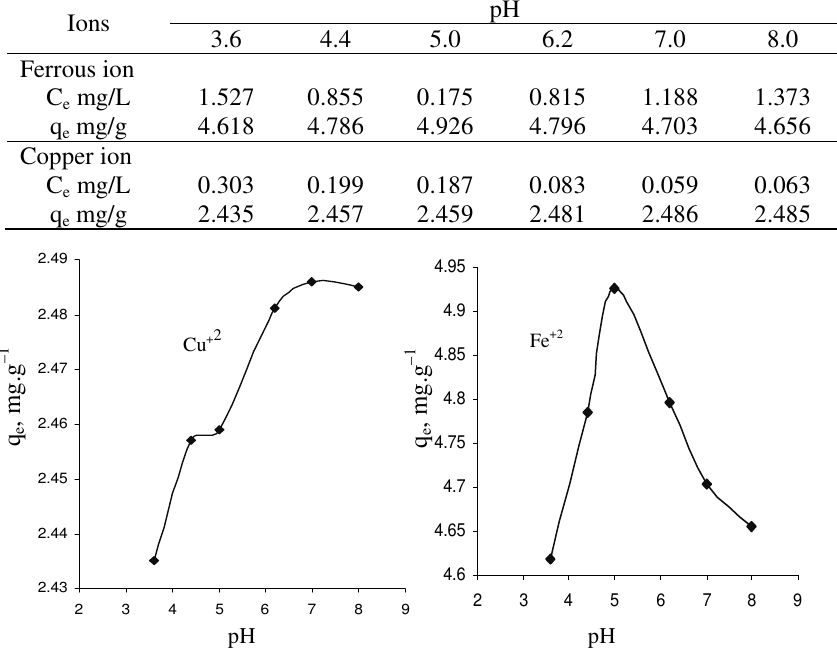
Figure 1. Effect of pH on removal of ferrous and copper ions onto pine fruit